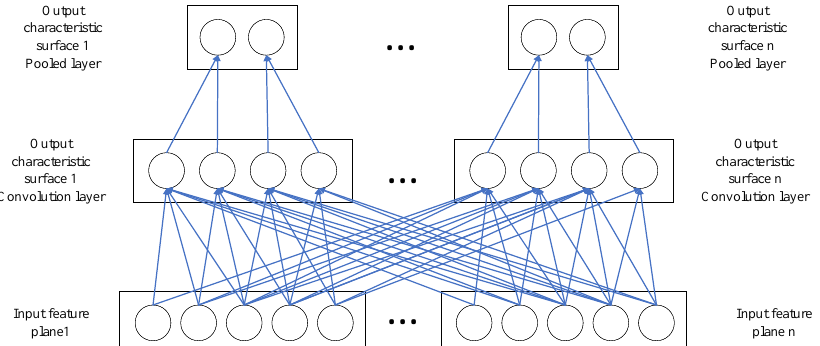
Figure 2. Schematic diagram of the convolutional layer and the pooling layer